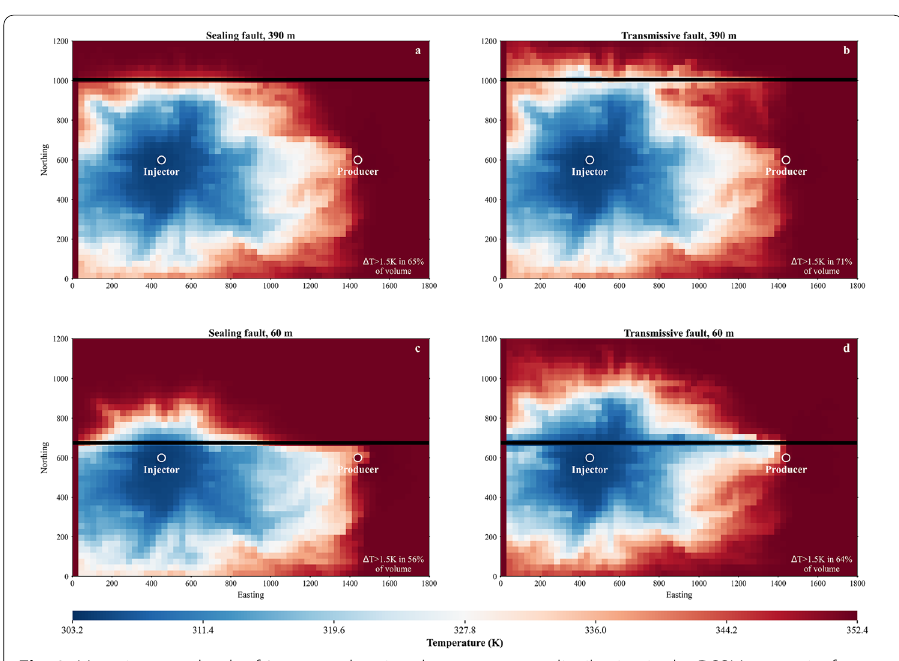
Fig. 8 Map view at a depth of 2177.5 m showing the temperature distribution in the DSSM reservoir after 30 years of production with an FWD of 390 m ( a , b ) and 60 m ( c , d ) for a sealing ( a , c ) and a transmissive fault ( b , d ). Data shown use an injection temperature of 303.15 K and a flowrate of 9000 m 3 /day. Injector and producer wells are marked with a blue and red point respectively and the fault position is indicated in black. The notation on the bottom right shows the volume percentage that exhibits a � T > 1.5 K after 30 years of simulation compared to the initial reservoir temperature. The percentage is calculated throughout the whole reservoir volume and it is not limited to the horizontal cross-section shown